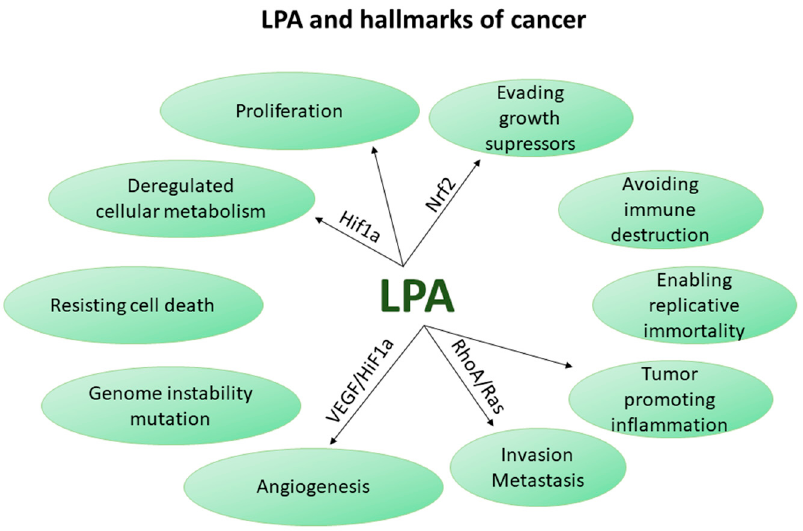
Figure 2. Hallmarks of cancer, as presented in Reference [107], and their relation to LPA. VEGF: vascular endothelial growth factor; HiF-1 α : Hypoxia Inducible Factor 1 Subunit Alpha; RhoA: Ras homolog gene A; Nrf2: Nuclear factor erythroid 2-related factor 2.